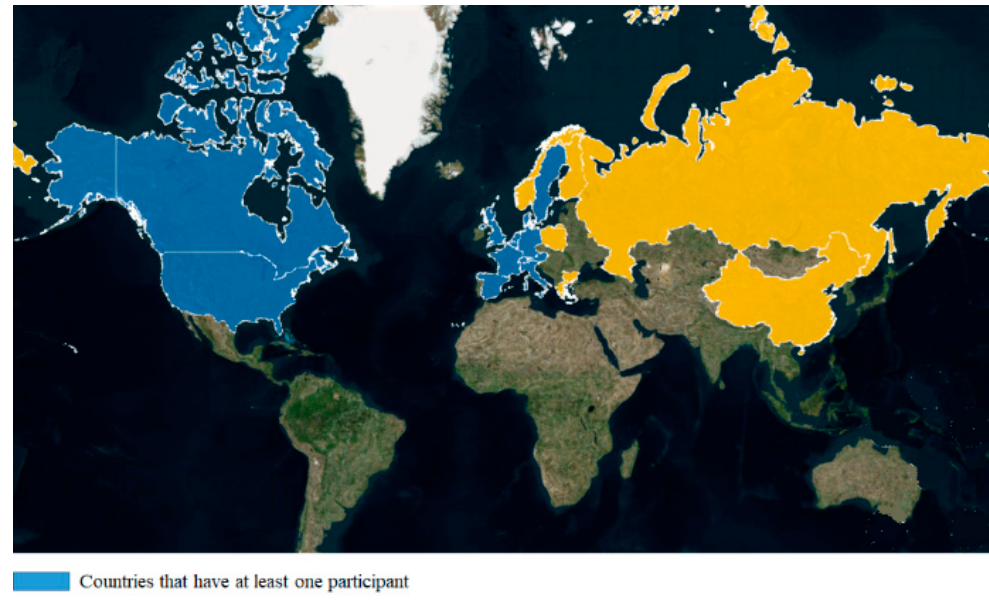
Figure 1. Countries that have at least one participant and countries that were invited to the survey but did not participate.